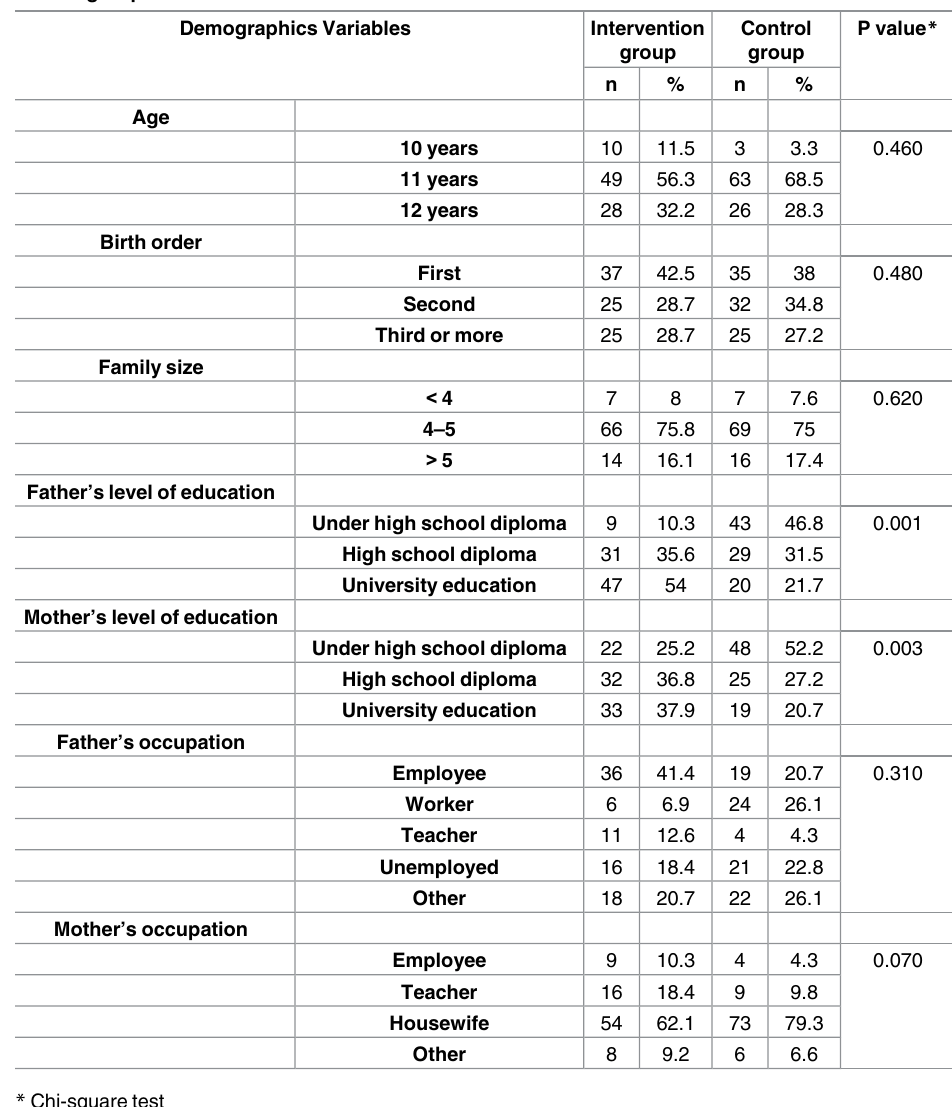
Table 1. Frequency distribution of the students’ demographic information in the intervention and control groups. Demographics Variables Intervention